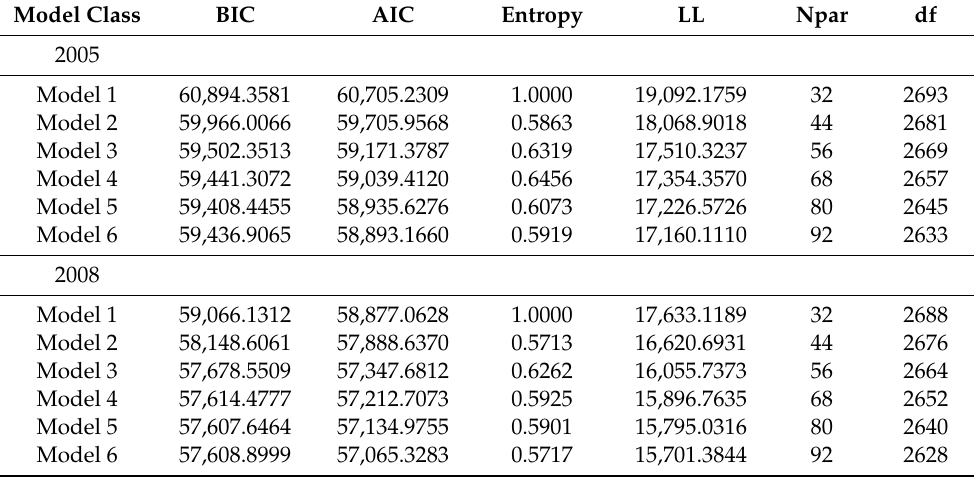
Table 3. Latent class analysis fit